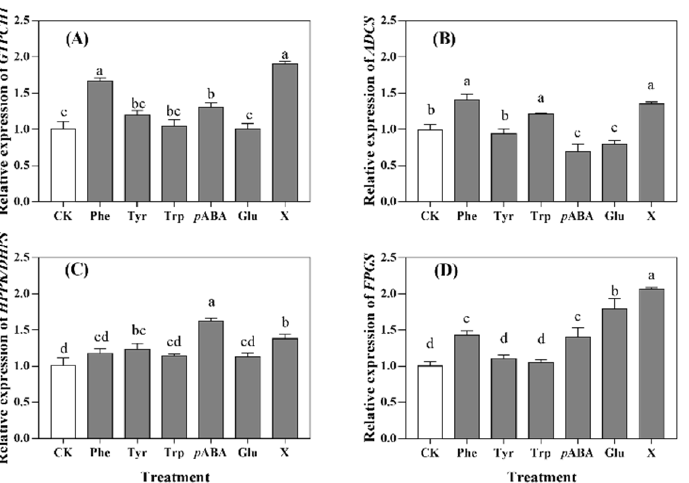
Figure 4. Relative expression of GTPCHI ( A ), ADCS ( B ), HPPK / DHPS ( C ) and FPGS ( D ) under treatments of different amino acid. CK was wheat seedlings cultured with distilled water; Phe, Tyr, Trp, p ABA, and Glu were seedlings cultured with 1.00 mM phenylalanine, 0.25 mM tyrosine, 0.50 mM tryptophan, 0.25 mM p -aminobenzoic acid, and 1.00 mM glutamate, respectively; X was seedlings cultured with the optimized culture solution (1.50 mM phenylalanine, 0.50 mM tyrosine, 0.50 mM tryptophan, 0.75 mM p -aminobenzoic acid, and 0.50 mM glutamate). a–d represent significant differences among treatment factors ( p < 0.05).